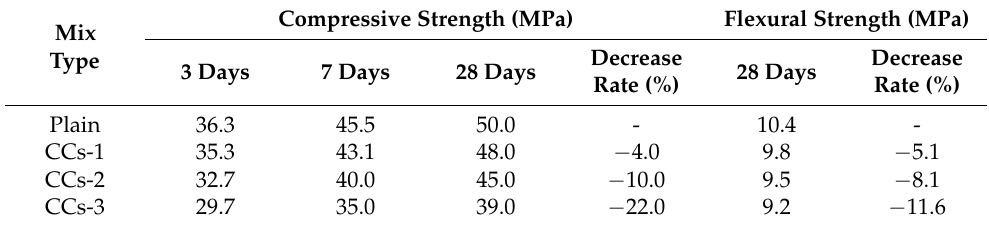
Table 5. Characteristics of the hardening state of the cement